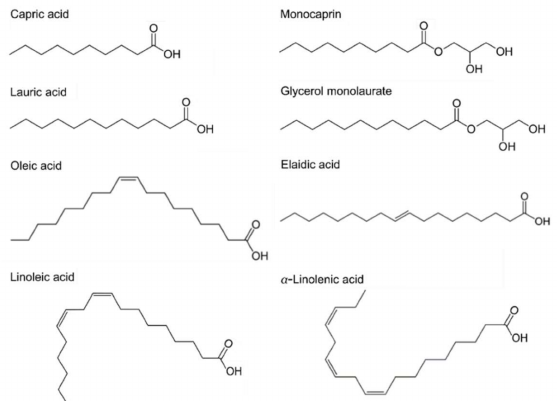
Figure 1. Chemical structures of fatty acids and monoglycerides. Saturated fatty acids; Capric acid (C10:0), LA (C12:0). Monoglycerides; Monocaprin (MG C10:0), Glycerol monolaurate (MG